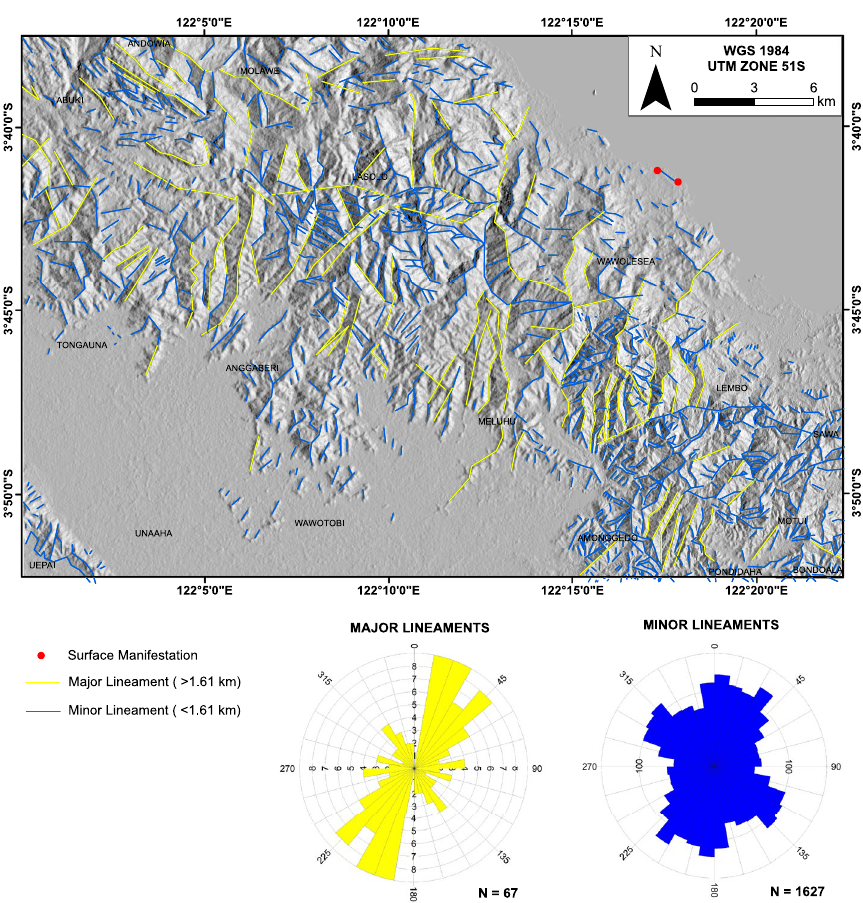
Fig. 9 Map of lineaments clusterization based on the lineaments lengths and lineament orientation (major lineament in yellow; minor lineament in blue)